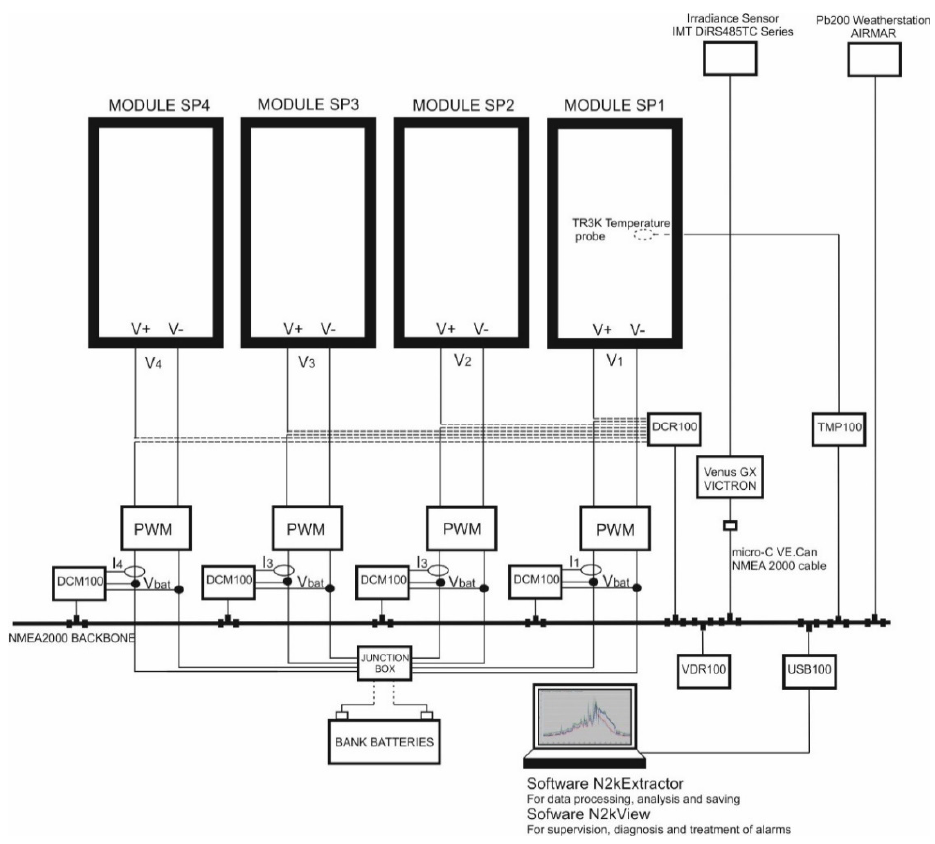
Figure 6. PVMs system installation.